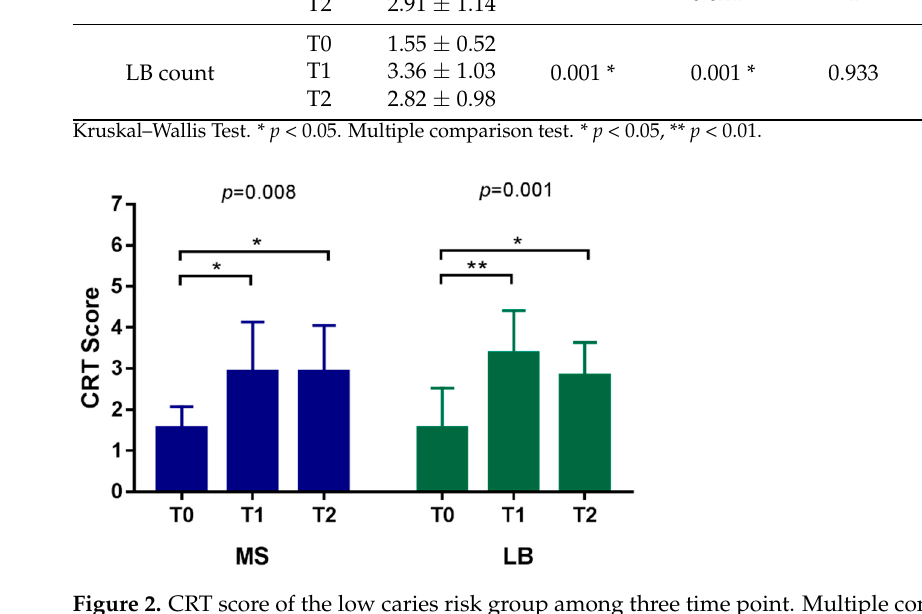
Figure 2. CRT score of the low caries risk group among three time point. Multiple comparison test. * p < 0.05, ** p < 0.01.Table 4 and Figure 3 present the changes in the cariogenic bacterial count among the three time points in the high caries risk group. There were no statistically significant changes in the MS count among the three time points; for LB count, there were significant changes among the three time points ( p = 0.014). Multiple comparisons revealed that significant changes occurred at T0–T1 ( p = 0.011). Table 4. CRT score of the high-caries-risk group among three time points.